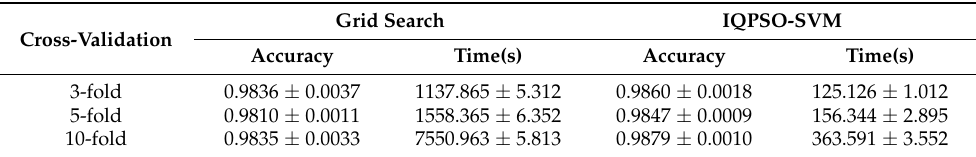
Figure 7. Relationship between the number of iterations and accuracy of IQPSO-SVM. Table 4. Grid Search and IQPSO-SVM performance comparison. Table 4. Grid Search and IQPSO-SVM performance comparison.